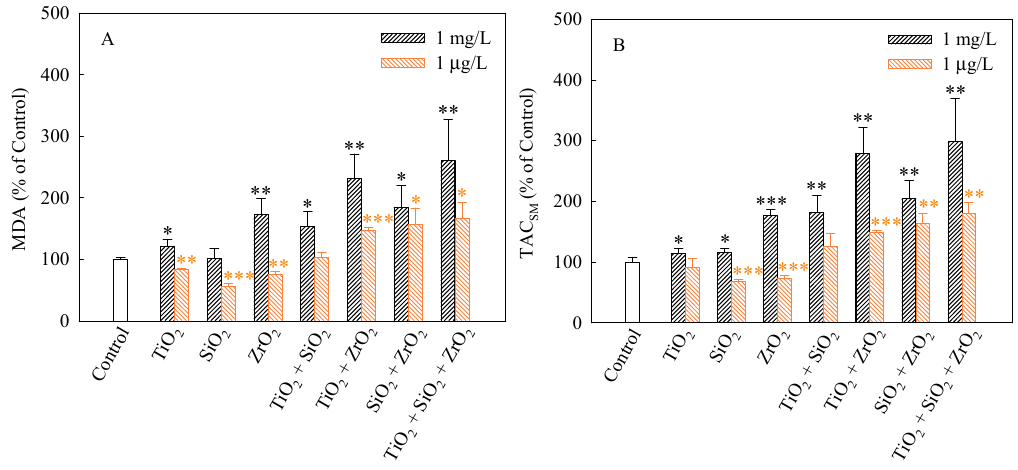
Figure 5. Levels of MDA ( A ) and TAC SM ( B ) in S. obliquus exposed to 1 mg/L and 1 μ g/L of NPs alone, 1 mg/L and 1 μ g/L of single NPs in binary combination and 1 mg/L and 1 μ g/L of single NPs in ternary combination. Statistical significance versus control group: * p < 0.05, ** p < 0.01 and *** p < 0.001.